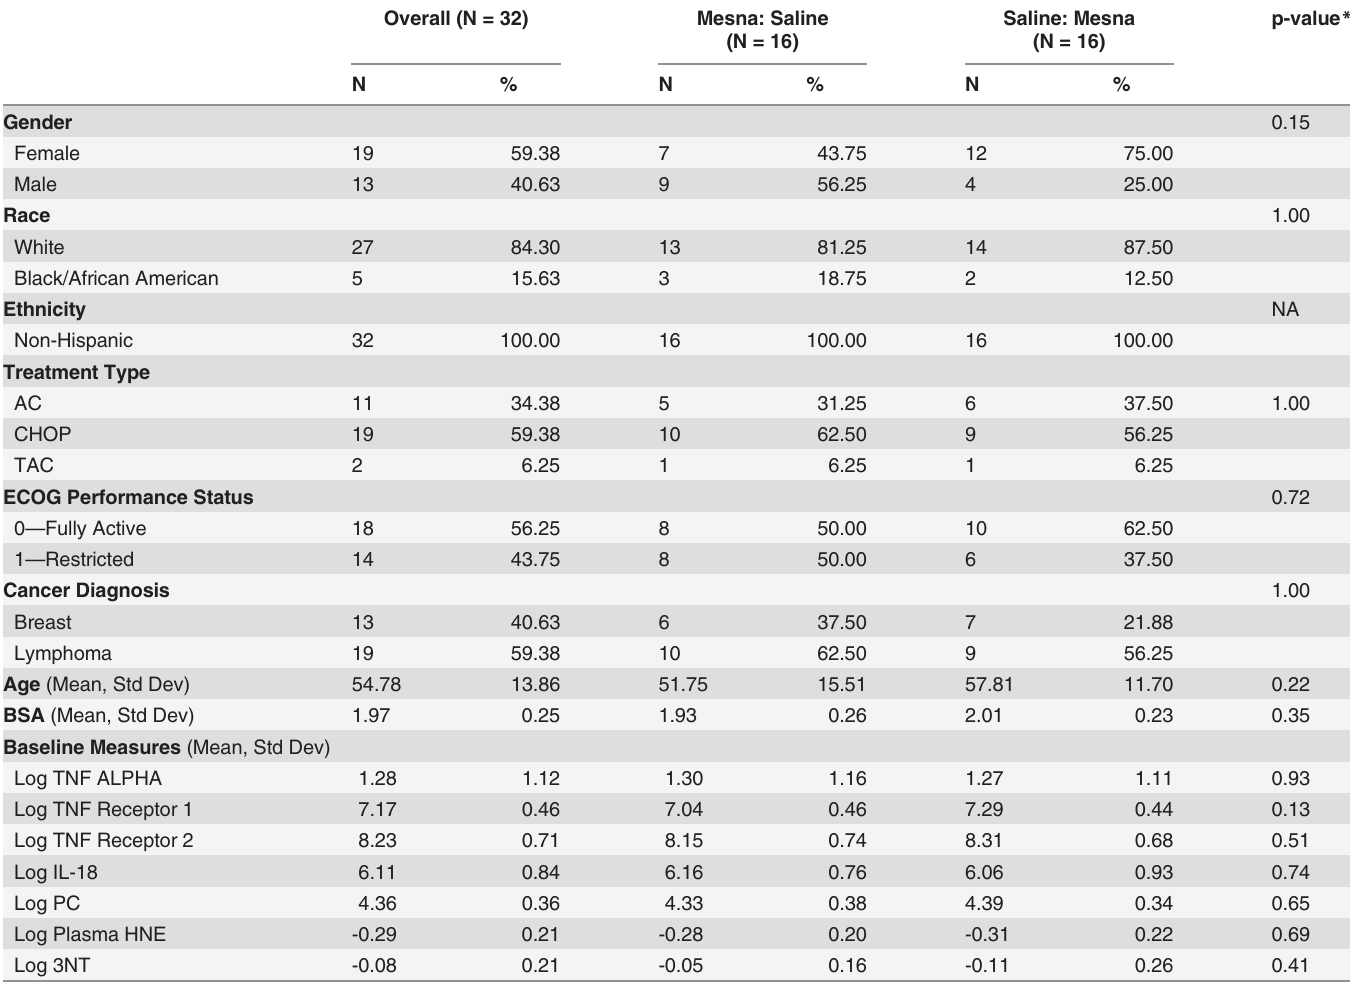
Table 1. Demographics for randomized subjects N =